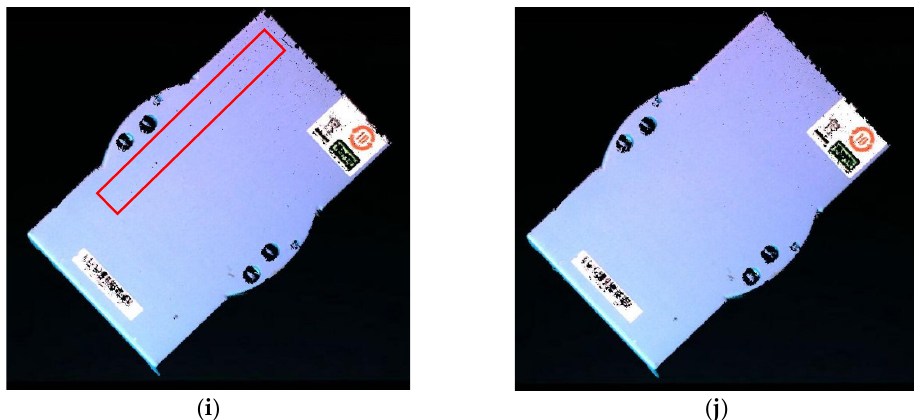
Figure 5. Comparison of the reconstruction results. ( a ) The traditional method ( grey anime dolls). ( b ) The proposed method ( grey anime dolls ). ( c ) The traditional method (colored puppets). ( d ) The proposed method (colored puppets). ( e ) The traditional method (colorful kittens). ( f ) The proposed method (colorful kittens). ( g ) The traditional method (air valves). ( h ) The proposed method (air valves). ( i ) The traditional method (flat). ( j ) The proposed method (flat).